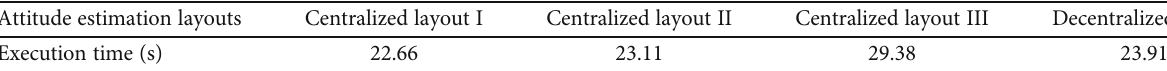
Table 5: Execution time.